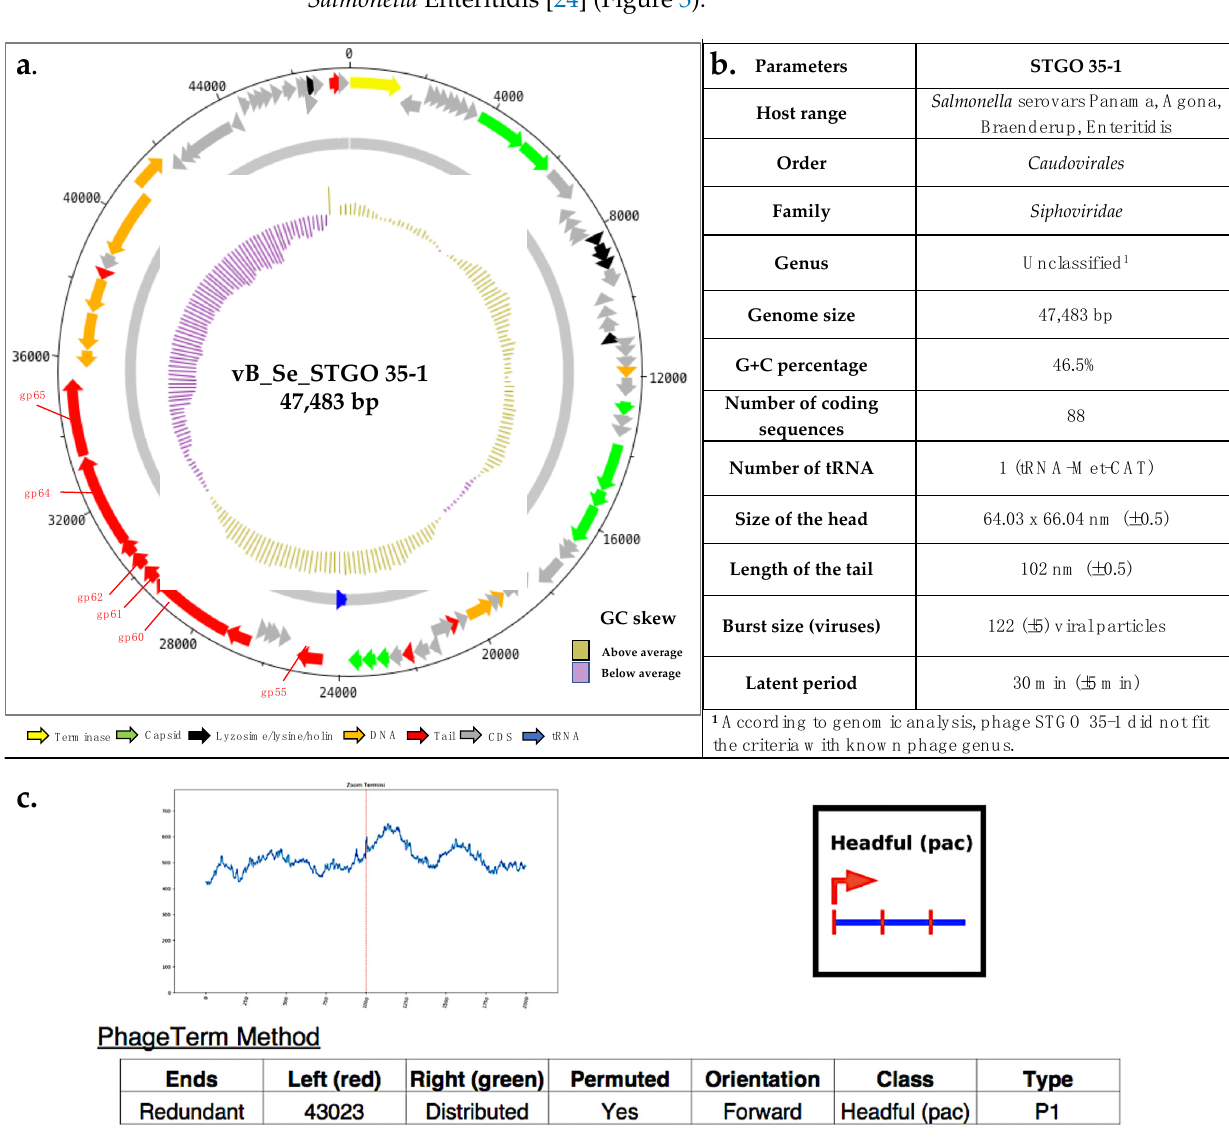
Figure 3. ( a ) Genome map of STGO-35-1, made with Artemis and DNAPlotter [52]. The color coding of genes indicates the functional categories of putative proteins: capsid proteins (green); lysozyme (black); CDSs and hypothetical proteins (gray); and tail proteins (red). The GC skew is represented in the inner circle and with purple indicating below average and yellow above average. ( b ) Genomic and phenotypic characterization of phage STGO 35-1. ( c ) The packaging strategies predicted in PhageTerm [25].